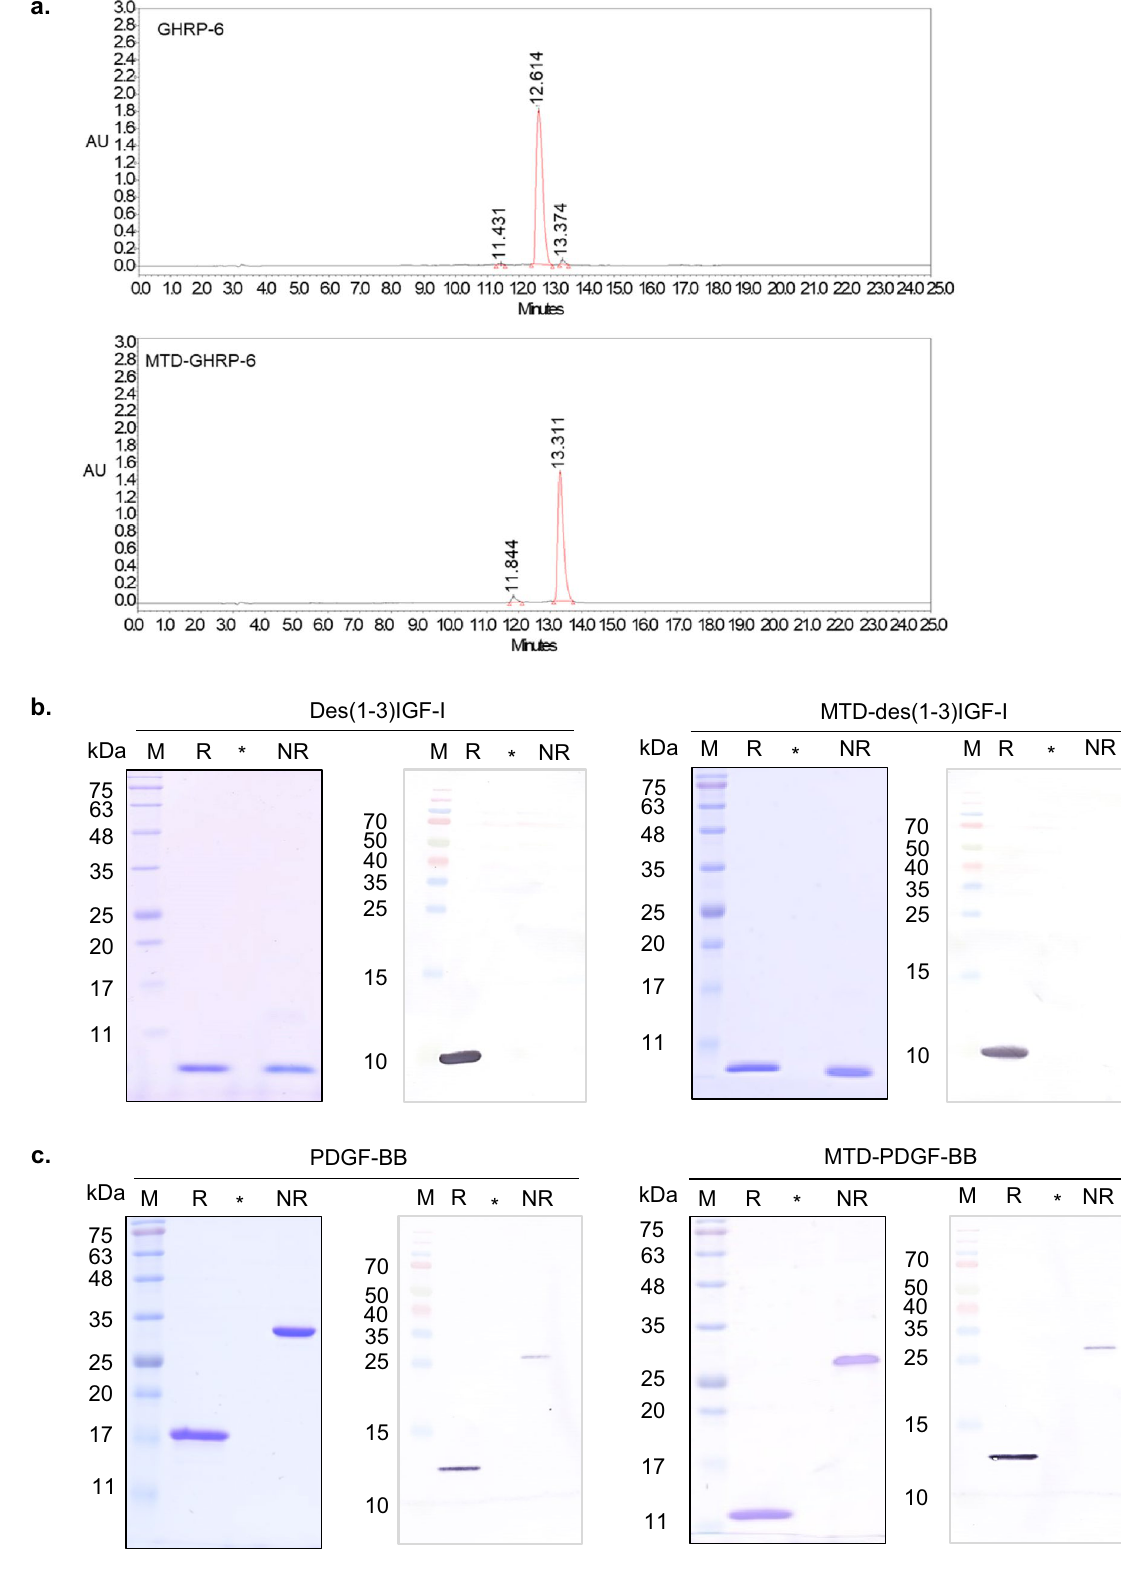
Figure 2. Purification of peptide and recombinant proteins. ( a ) RP-HPLC analysis of purified GHRP-6 and MTD-GHRP-6 peptides using the 20–60% solvent B gradient method for 25 min. ( b ) SDS-PAGE and western blot analysis of des(1-3)IGF-I and MTD-des(1-3)IGF-I proteins, ( c ) SDS-PAGE and western blot analysis of PDGF-BB and MTD-PDGF-BB proteins. M, molecular weight marker; R, reduced form; NR, non-reduced form; *, blank lane without sample loading. The raw data of western blot analysis in ( b ) and ( c ), respectively, were presented in Supplementary Information as Fig.